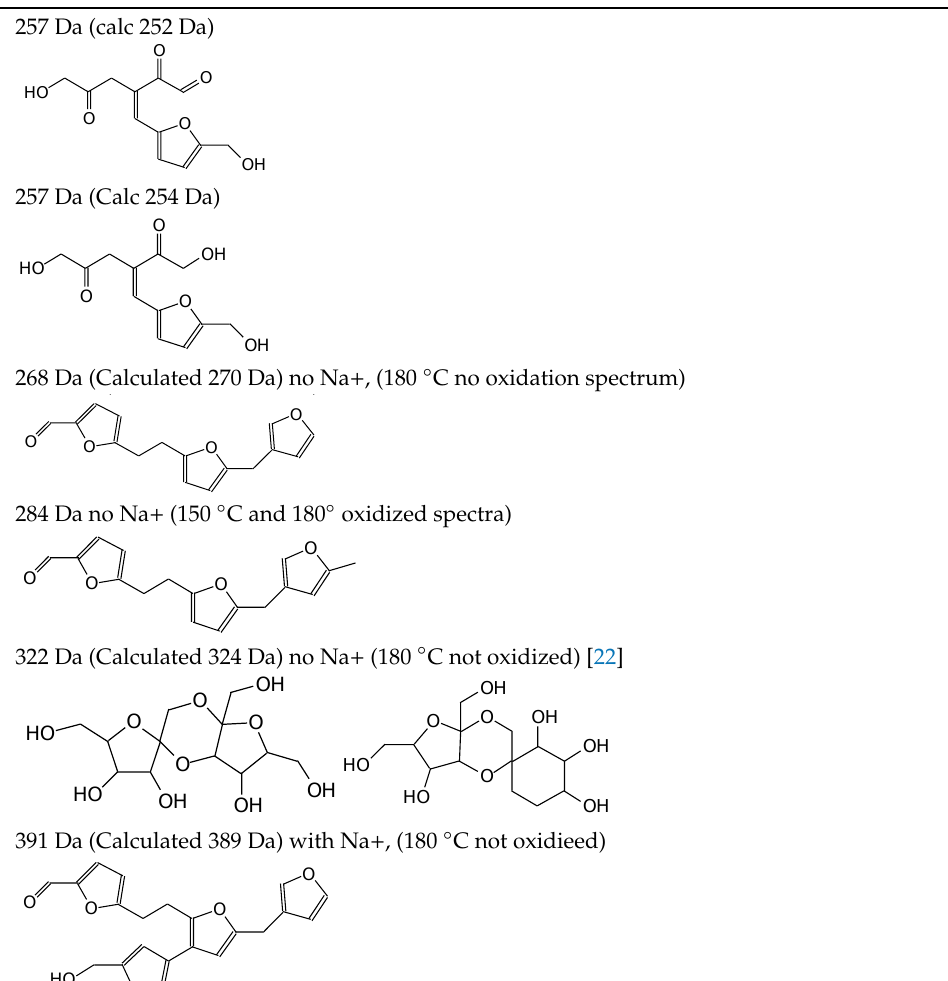
OHOH OH OO OH O O OO O HO OH HO HO OH HO OH OH 391 Da (Calculated 389 Da) with Na+, (180 °C not oxidieed) O O OO H O O 392 Da (Calculated 396 Da) (180 °C not oxidized) [22] O O O H O O OO OO OO H H O H O H 506 Da (no Na+) and 526 Da (with Na+) Calc.: 504 Da and 527 Da OO OO OO OO OO OO O H OO O H OO O H O OO OO OO H 623 Da (Calculated 623 Da) with Na+ (150 °C spectrum) O O OO O H OO H OOOO H 635 Da (with Na+) OO O H OO O H OO O H O O OO O H H 636 Da (Calculated 637 Da) with Na+, (180 °C not oxidized spectrum)